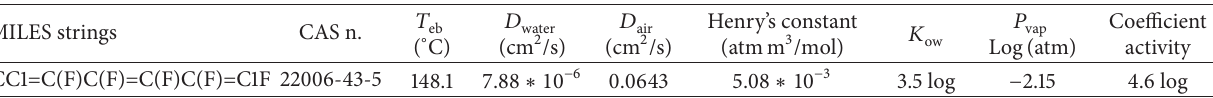
Table 1: Physical properties and partition coefficients of the fluoride-2,3,4,5,6-pentafluorobenzyl bromide ester derivative evaluated using SPARC software. SMILES strings CAS n.